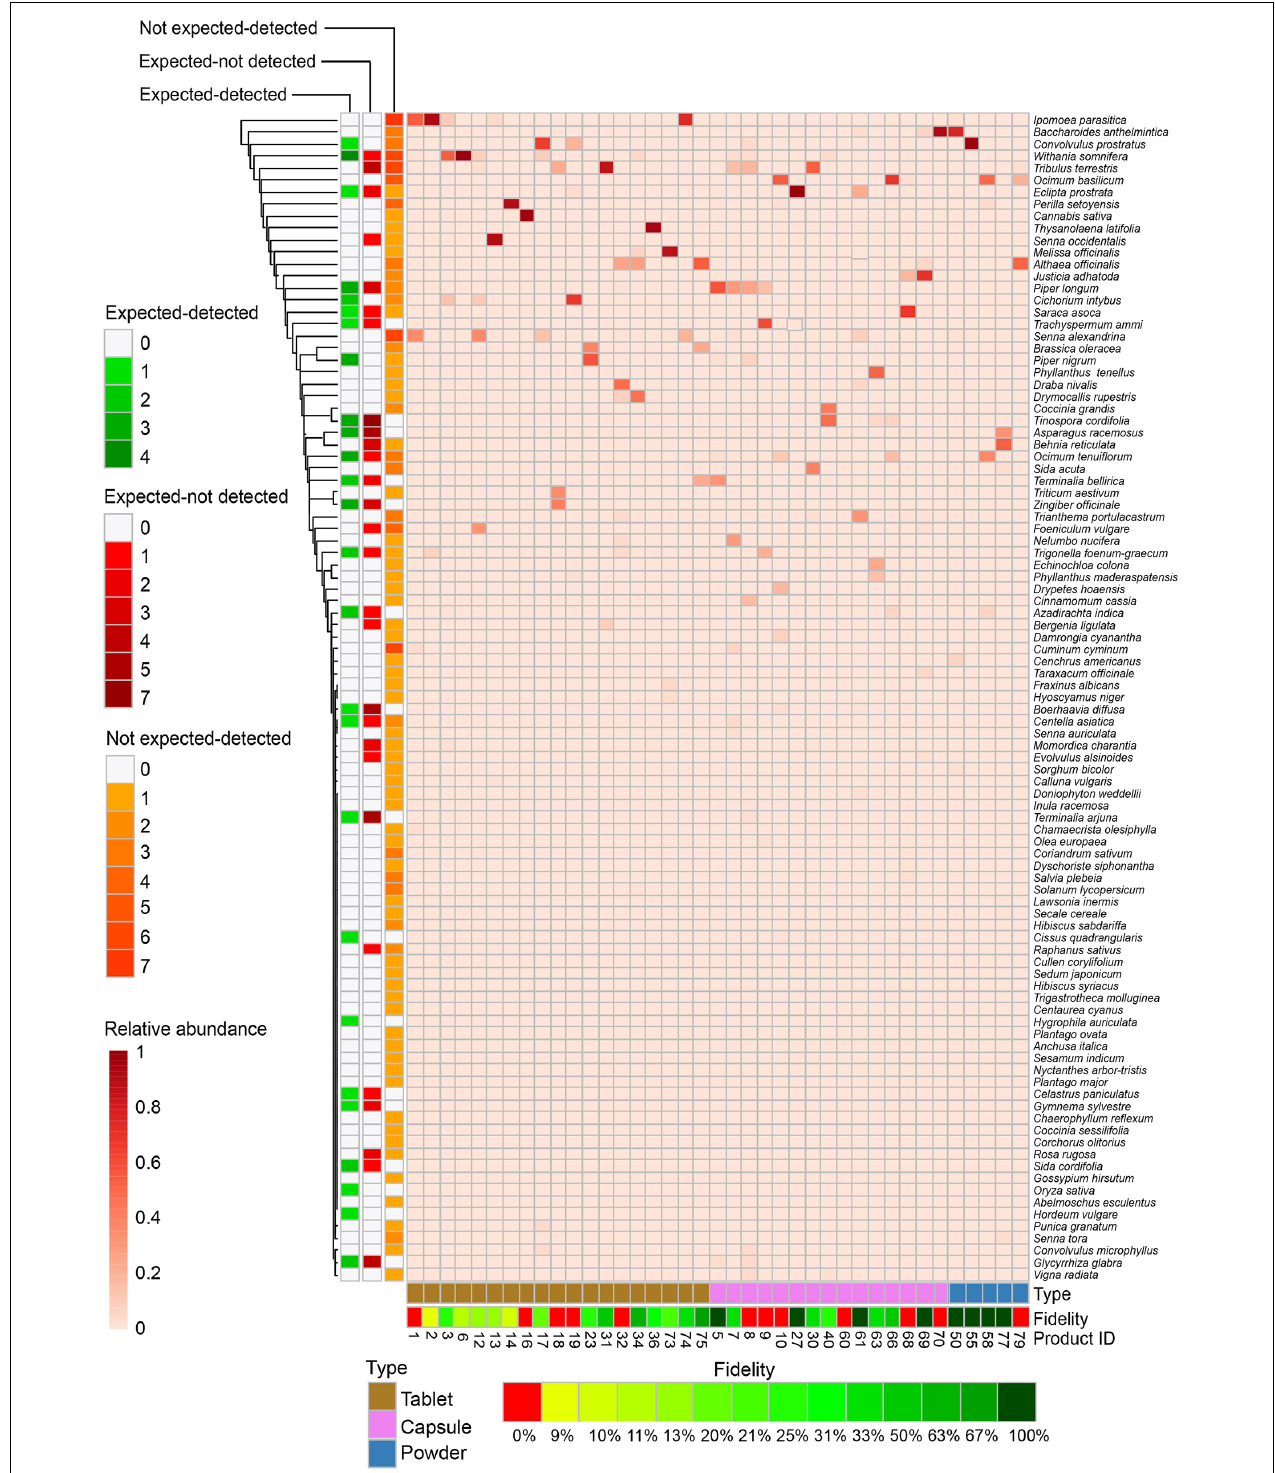
FIGURE 3 | Detection of species in Ayurvedic herbal products. Species (y-axis) are colored by relative abundance of normalized read numbers. Species are categorized in expected-detected and not expected-detected, based on the total number of occurrences, whereas the category expected-not detected is based on the number of times that the species is expected but not detected. Species are clustered by Euclidean distances. Ayurvedic samples (x-axis) are numbered with product code and grouped by product type.